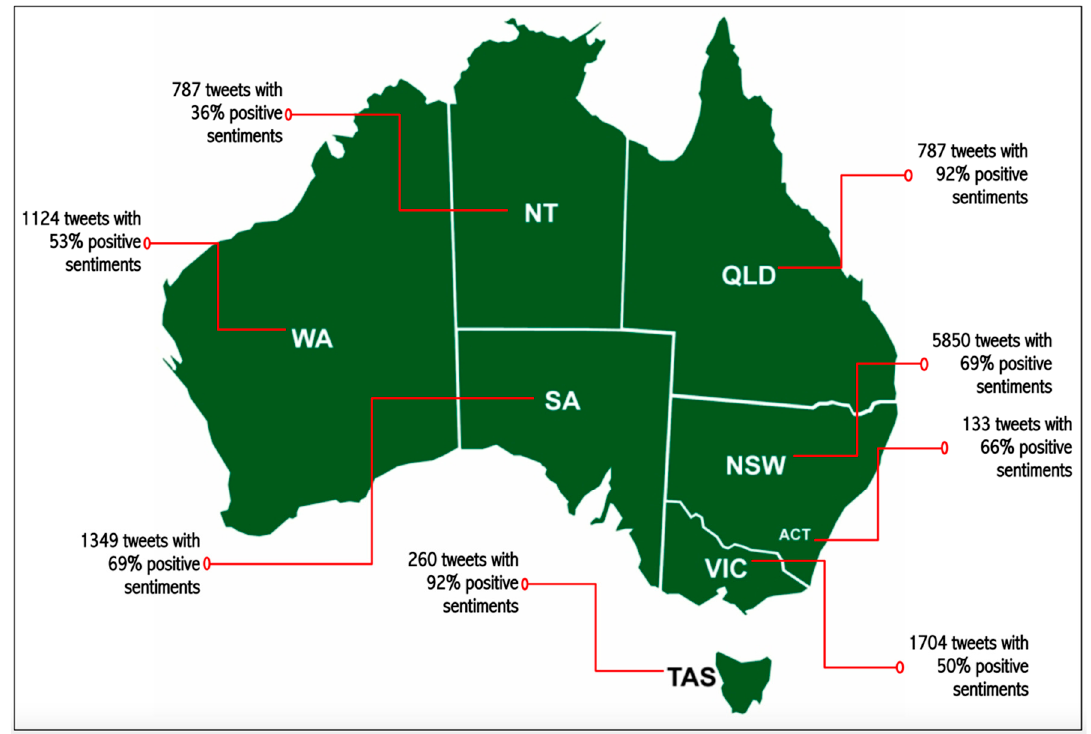
Figure 2. Tweet numbers and positive sentiment percentages by states and territories.